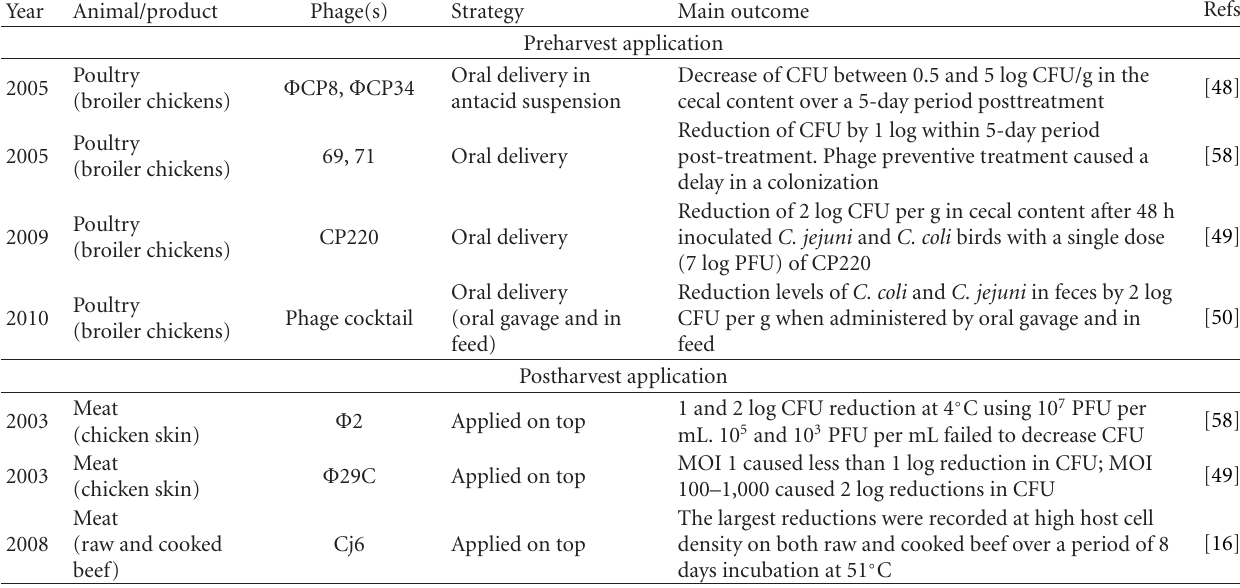
Table 2: Pre- and postharvest Campylobacter phage